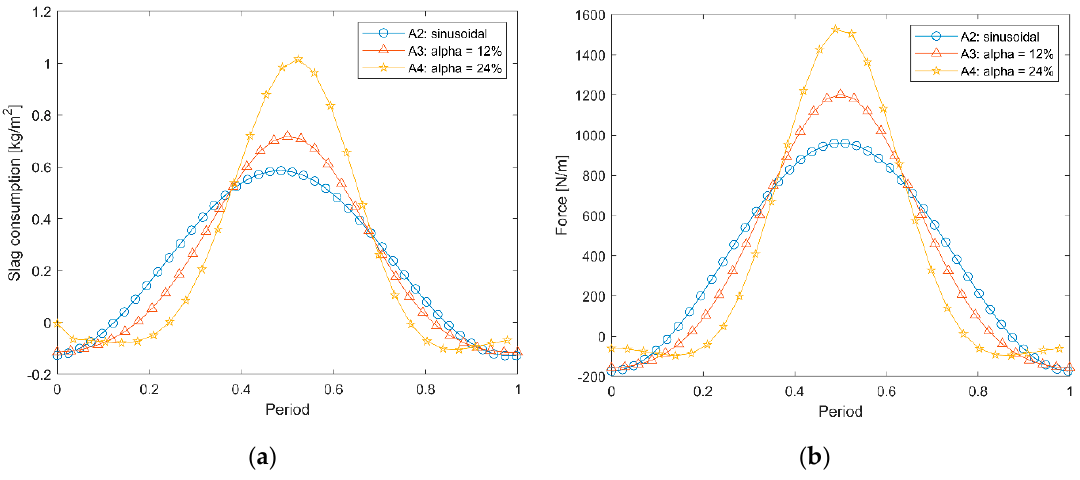
Figure 10. ( a ) Slag consumption (cid:1843) (cid:3039)(cid:3048)(cid:3029) and ( b ) force from slag pressure during the oscillation cycle.